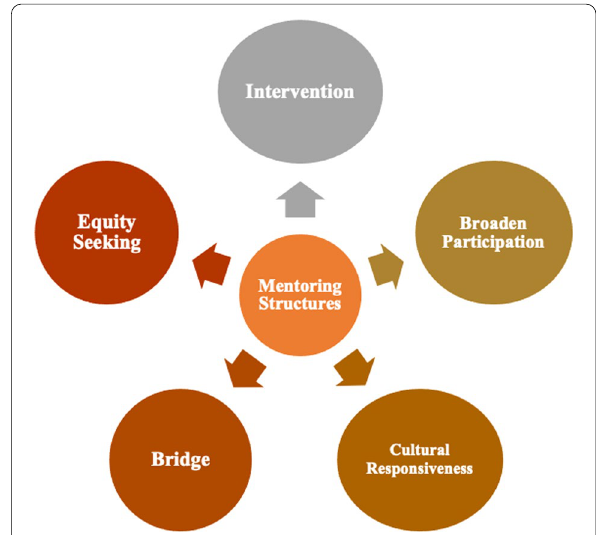
Fig. 2 The five mentoring structures in STEM HE that represent the reason for